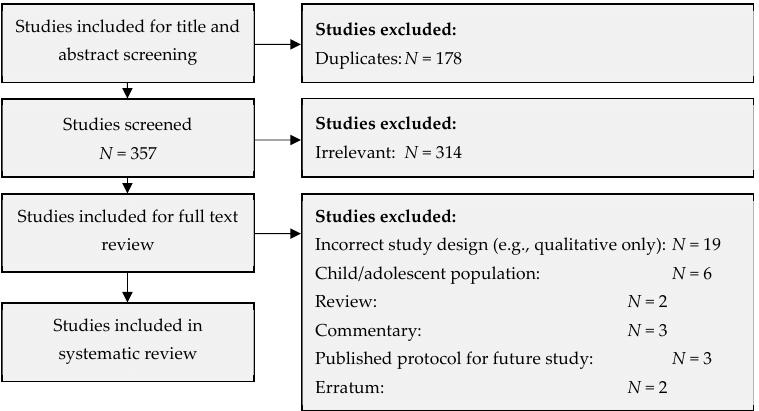
Figure 1. PRISMA flow diagram for the database search and review process .